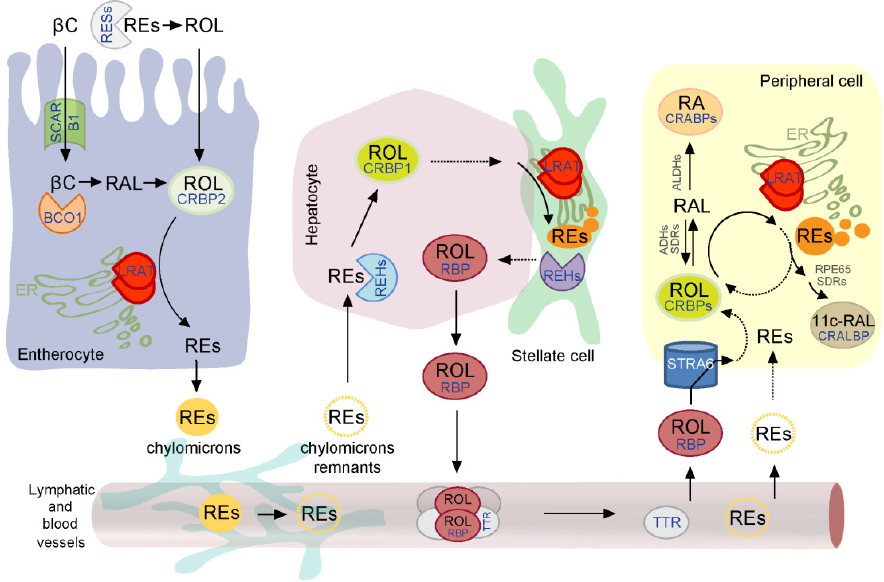
Figure 1. Diagram of the current model of vitamin A absorption, transport, and storage. Retinoid metabolism can be classified into three major processes—intestinal uptake, hepatic storage, and tissue ‐